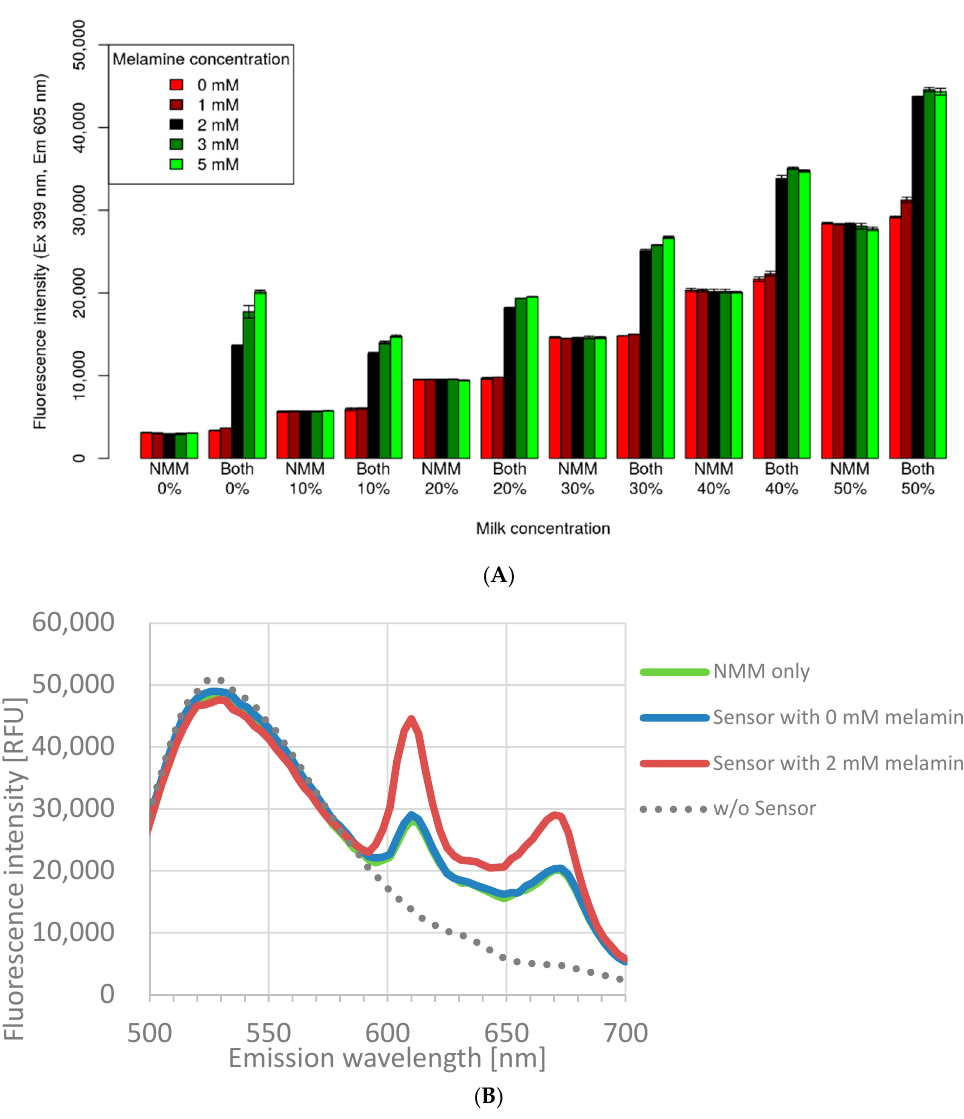
Figure 4. ( A ) Fluorescence intensity at different concentrations of milk and melamine. The N -methylmesoporphyrin IX (NMM) and both labels at the bottom of the bar chart represent NMM alone and NMM with the biosensor, respectively. The milk concentration is also shown at the bottom of the bar plot and ranged from 0% to 50%. The color represents melamine concentrations from 0 mM to 5 mM. The excitation and emission wavelengths for excitation and emission were set at 399 nm and 605 nm, respectively. ( B ) Fluorescence spectra of NMM alone and of both NMM and melamine. The milk concentration was 50%, and the excitation wavelength was set to 399 nm. The green, blue, and red lines represent NMM alone with 0 nM melamine, NMM plus a biosensor with 0 mM melamine, and NMM plus biosensor at 2 mM melamine, respectively. The dotted line represents the fluorescence intensity of milk.